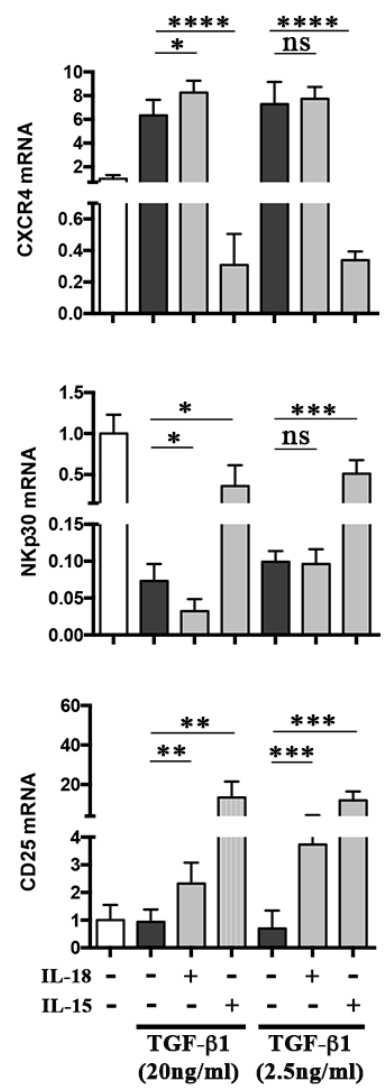
Figure 3. CXCR4 and NKp30 mRNA expression in NK cells treated with TGF- β 1 plus IL-18. PB NK